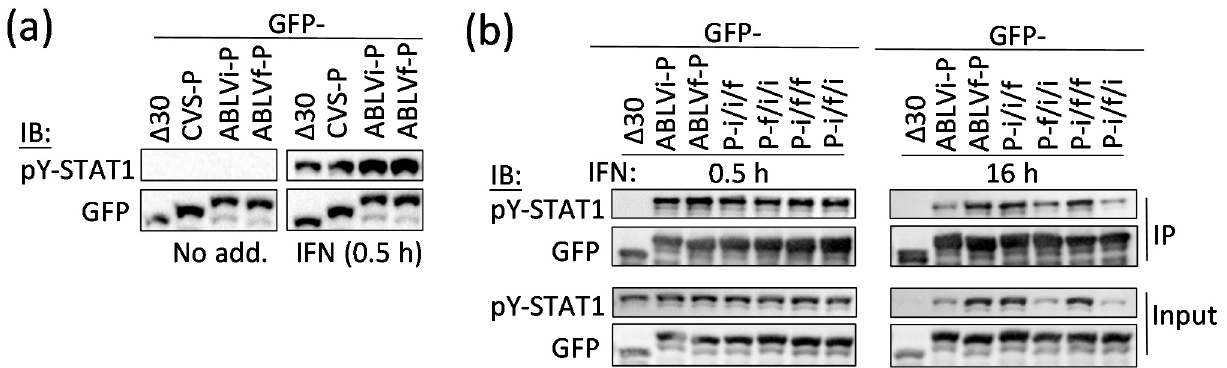
Figure 3. P protein–STAT1 interaction differs between ABLV P proteins and correlates with differing antagonist functions. ( a ) Cos-7 cells expressing the indicated proteins were treated with or without 1000 U/mL IFN α for 0.5 h before lysis and analysis by IB for Y701-phosphorylated STAT1 (pY-STAT1) and GFP. ( b ) Cells expressing the indicated proteins were treated for 0.5 and 16 h with IFN before IP for GFP and analysis of lysate (input) and IP by IB. Results representative of 3 experiments.